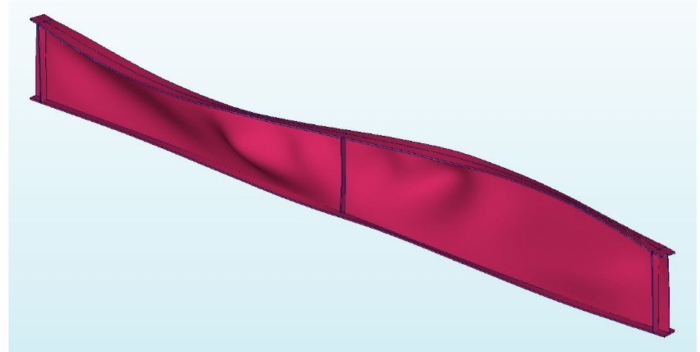
Figure A3. The 6th buckling mode, α cr = 10.5, scale × 2, computer code